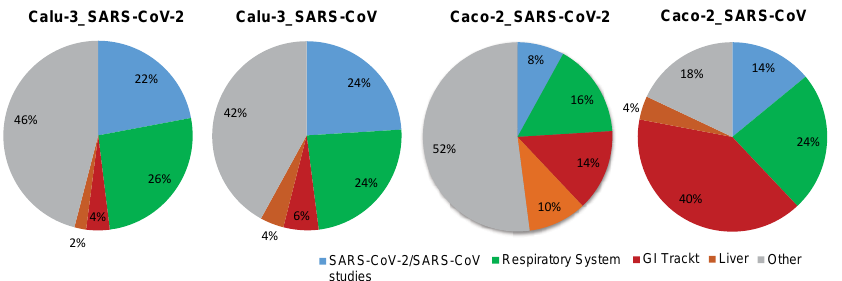
Figure 4. The tissue type-specific nature of cellular responses to infection with SARS-CoV-2 or SARS-CoV. The pie chart illustrates the outcome of a comprehensive analysis, including (i) the extraction of differentially expressed genes, (ii) the assessment of conditions with similarity to the differentially expressed genes-based signature, and (iii) the alignment with the listed categories. The final outcome is shown in the form of pie charts. Color code: blue , SARS-CoV-2 and SARS-CoV-attributed studies; green , studies attributed to the respiratory system; red , studies attributed to the gastrointestinal (GI) tract; orange , studies attributed to the liver; grey , all other studies that are not part of the above-described categories. Included into the analysis are Calu-3 cells, of lung origin, and Caco-2 cells, of colonic origin, infected with SARS-CoV-2 or SARS-CoV (time point: 24 h post infection). The underlying GENEVESTIGATOR-based analyses were performed, and the corresponding data were extracted in September 2020.